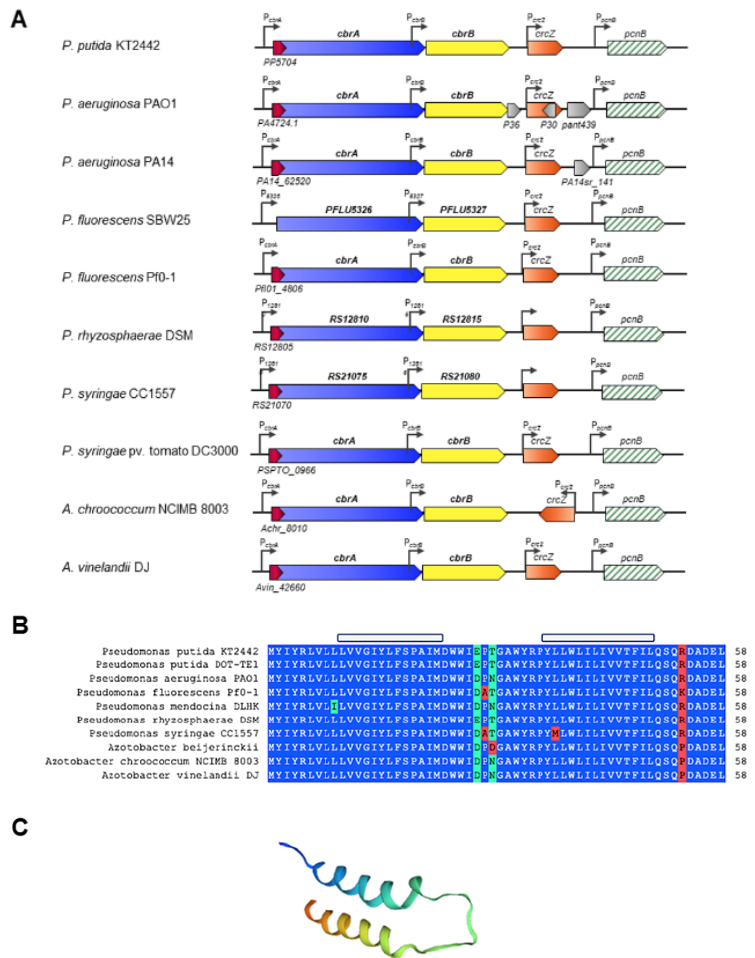
Figure 2. ( A ) Genomic organization of the cbrA–cbrB–crcZ locus in the family Pseudomonadaceae . Graphical representation of the gene organization of cbrX (burgundy), cbrA (blue), cbrB (yellow) and crcZ (orange) in P. putida KT2442, P. aeruginosa PAO1, P. aeruginosa PA14, P. fluorescens SBW25, P. fluorescens Pf0-1, P. rhyzosphaerae DSM 16299, P. syringae CC1557, P. syringae pv. tomato DC3000, A. chroococcum NCIMB 8003 and A. vinelandii DJ. Promoter regions are shown as arrows, other putative piRNAs in grey and adjacent genes in green. ( B ) Sequence alignment of CbrX in different strains of the Pseudomonadaceae family. Identical amino acids are indicated in blue, amino acids with similar physicochemical characteristics in green and non-conserved amino acids in red. Sequences corresponding to the α -helices depicted in panel B are indicated at the top of the sequence. ( C ) Secondary structure of CbrX predicted by homology modelling of protein structures by SWISS-MODEL (ExPASy).